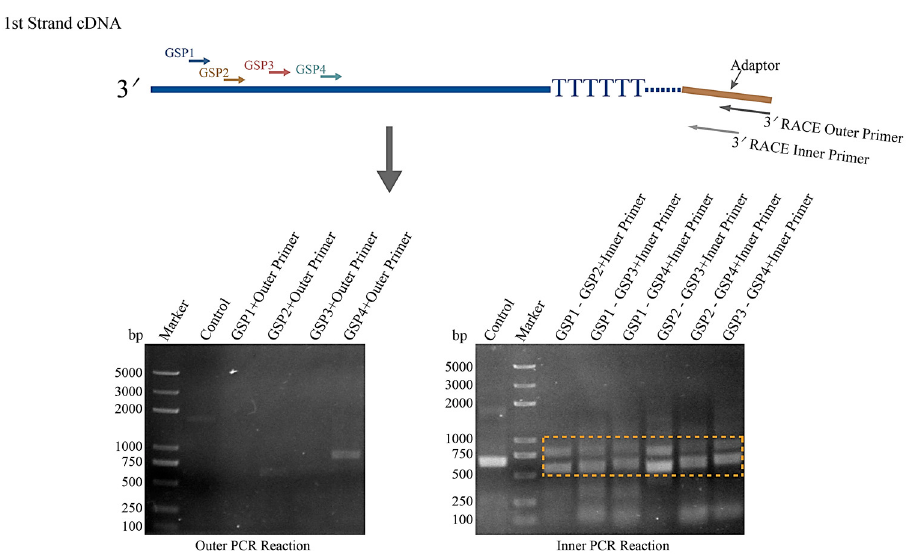
Figure 2. 3 ′ RACE analysis of the transcription isoforms of HNbTRAP α . The nested PCR process of 3 ′ RACE analysis is shown in the schematic diagram. The 1st strand cDNA with an adaptor at the 3 ′ terminal was obtained by reverse transcription. The outer PCR reactions were performed using the 3 ′ RACE outer primer paired with GSP1, GSP2, GSP3, and GSP4, respectively. Then, the inner PCR reactions were performed using the outer PCR products as templates, and ampli fi ed with GSP2, GSP3, and GSP4 as speci fi c upstream primers, respectively. The outer and inner PCR products were separated using 1.5% agarose gel. In the fi rst ampli fi cation, only GSP2 and GSP4 obtained two weak bands at 500~750 bp and 750~1000 bp, respectively. Two strong bands (500~750 bp and 750~1000 bp) were detected after the inner PCR reaction, and the products indicated in the yellow rectangle were recovered and cloned, respectively, for sequencing.